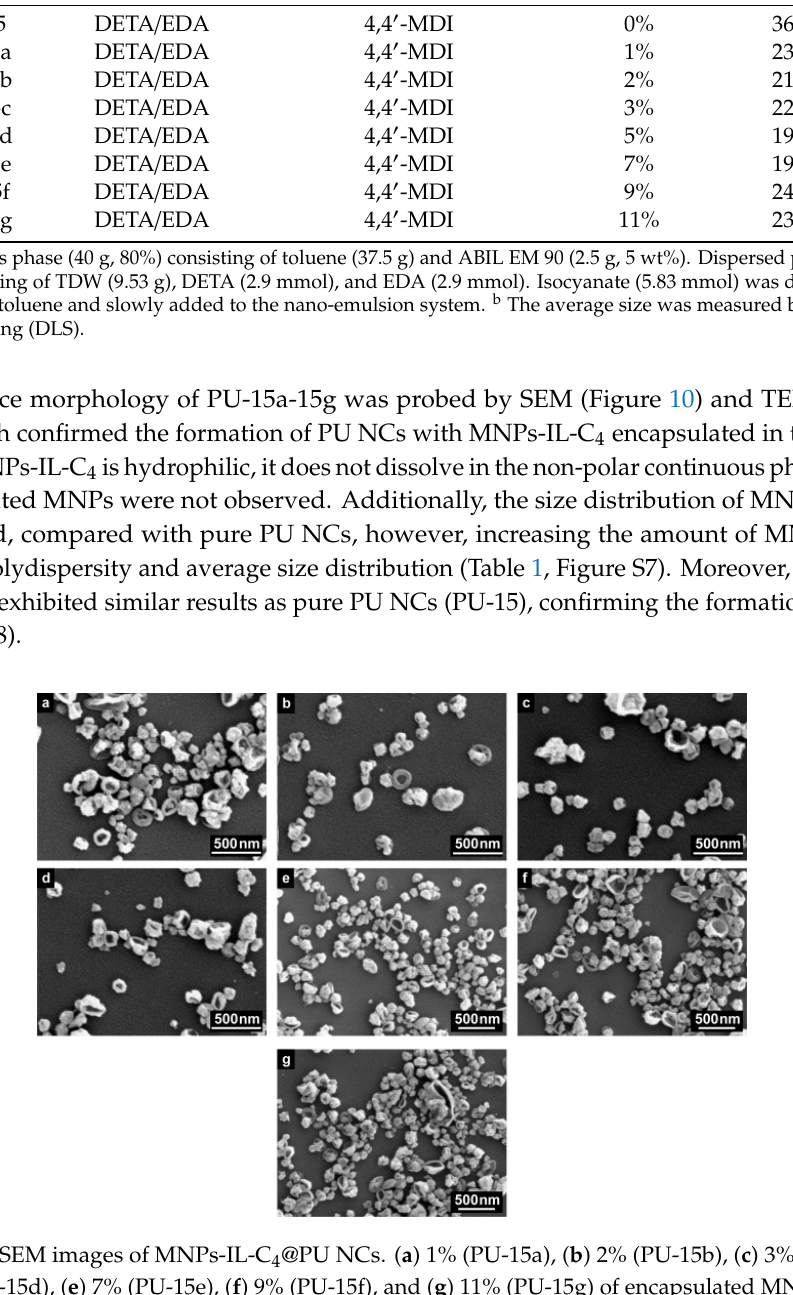
Table 1. Composition and encapsulation of MNPs-IL-C 4 in PU-15 a .